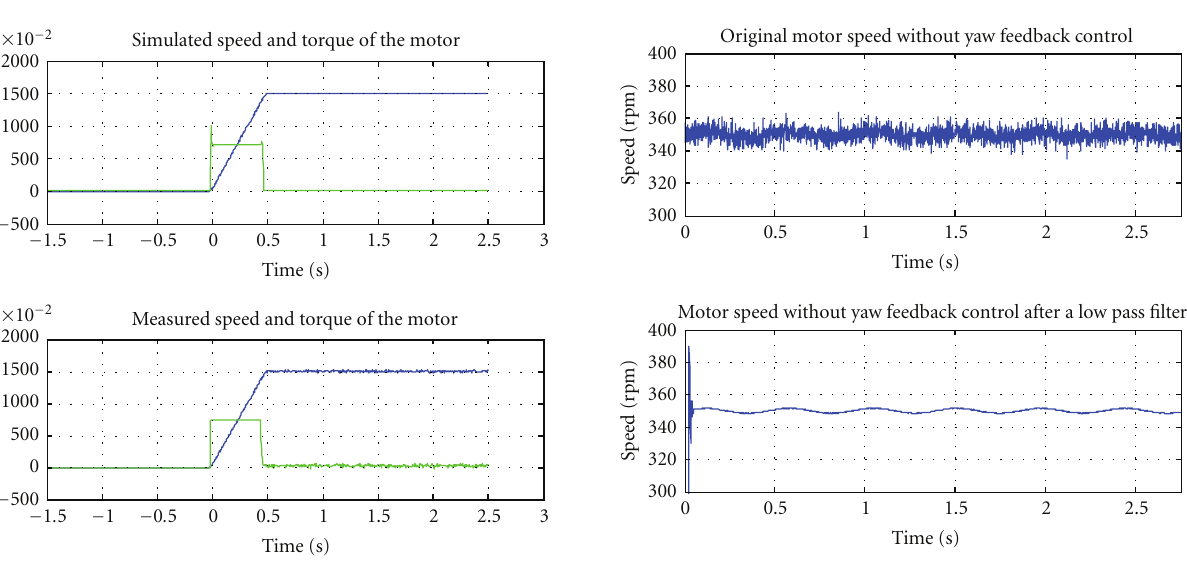
Figure 11: The measured wheel speed without yaw feedback control.